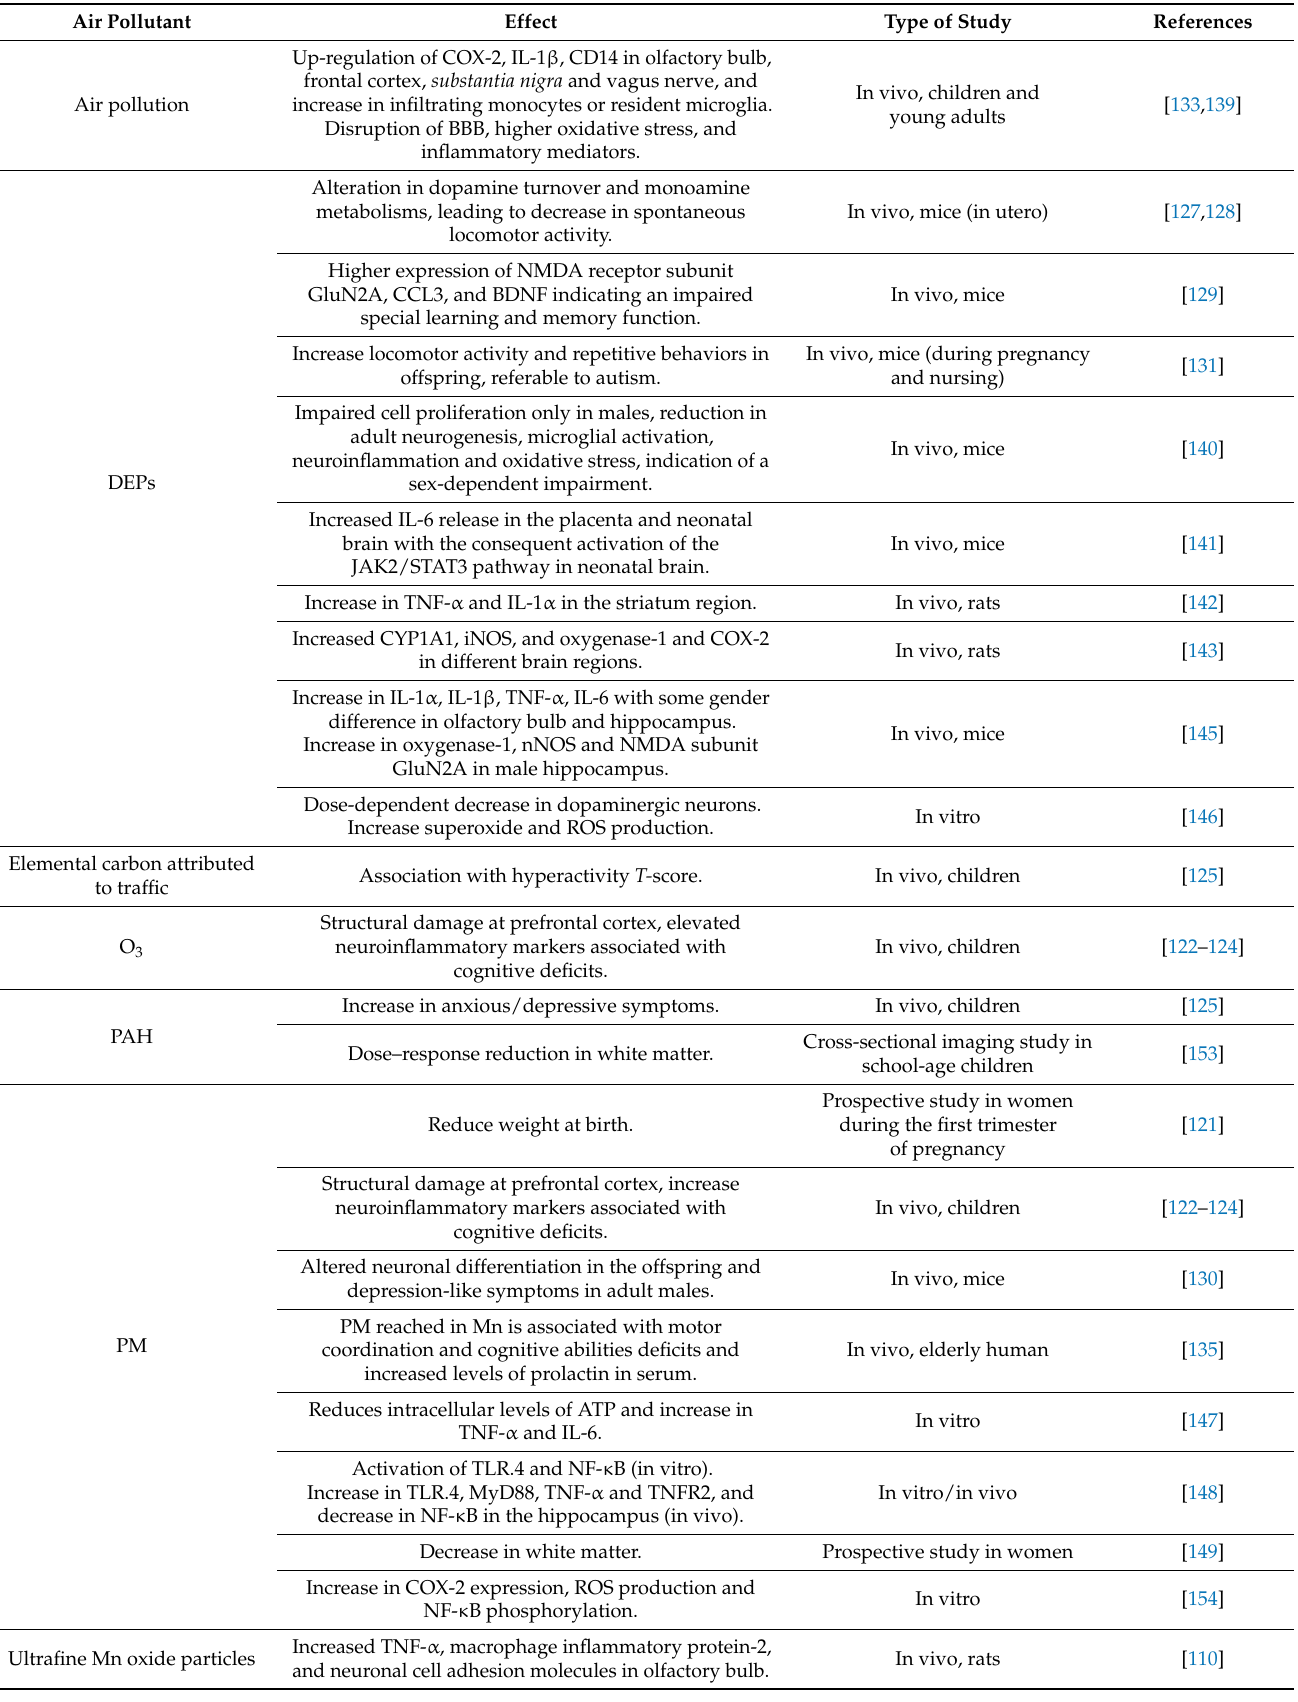
Table 3. Summary of air pollutant effects on the nervous